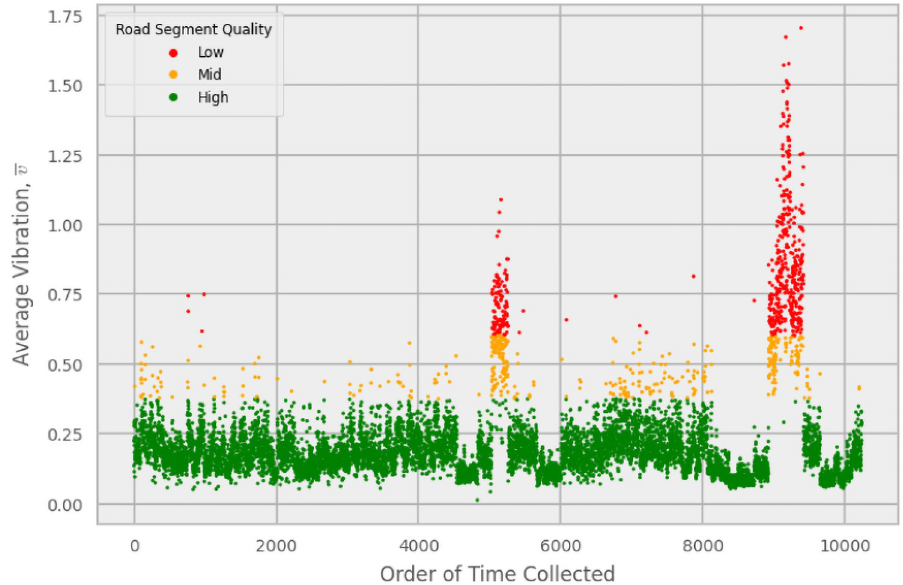
Fig 1. Average vibrations. Plot of the average vibrations, � v , for an individual device in the order of time collected, corresponding to dates between September 4th and November 26th, 2020. In this case, � v in the direction of the center- of-Earth to sky axis was used. Each point represents a road segment. The quality thresholds for this setup were determined to be 0.375 and 0.600, where points falling below � v ¼ 0 : 375 represent high quality roads, those above � v ¼ 0 : 600 are low quality, and points in-between are mid-quality. The spike on the right corresponds to a particular drive on dirt roads in the Appalachians near Blacksburg, VA, USA.